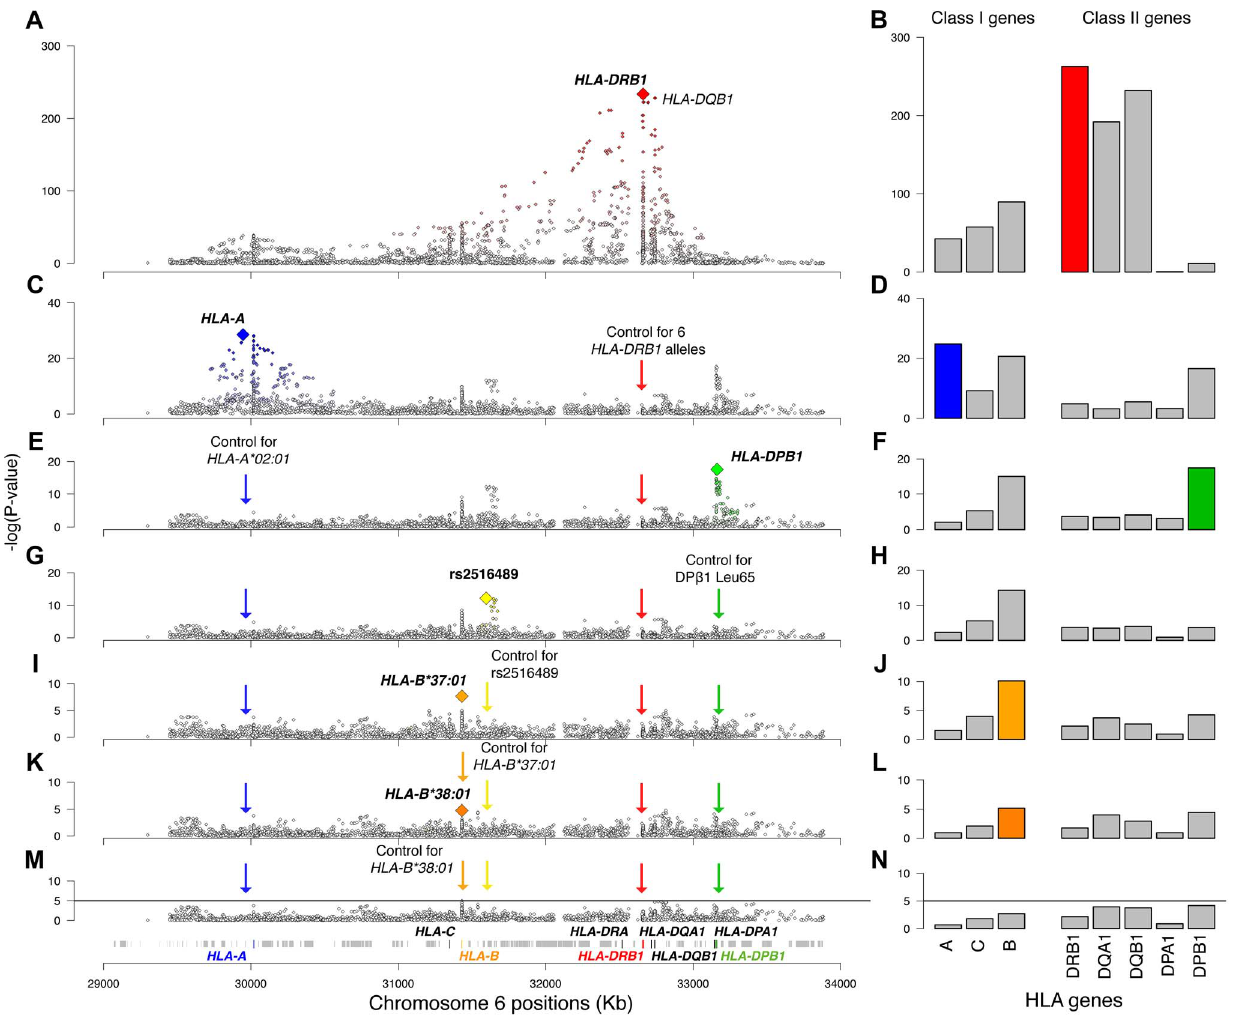
Figure 1. Association plots for the analyzed variants and HLA genes. Panels on the left are regional association plots for all variants in the MHC region; each diamond is a polymorphism evaluated in the analysis (SNP, HLA type, amino acid). The index variant that best captures the effect of each locus is highlighted with a larger diamond. Variants that are in LD with the index variant are colored, with the intensity of the color being proportional to the extent of LD. The panels on the right plot the 2 log 10 (p-value) of the eight analyzed HLA genes. The order of the genes is based on their position on chromosome 6. The rows represent univariate analysis (A, B), conditioning on six HLA-DRB1 alleles (*15:01, *03:01, *13:03, *04:04, *04:01, and *14:01) (C, D), conditioning on the above and HLA-A*02:01 (E, F), conditioning on the above and the DPB1 effect (G, H), conditioning on the above and rs2516489 (I, J), conditioning on the above and B*37:01 (K, L), conditioning on the above and B*38:01 (M, N). In panels M and N the solid black line marks the threshold of statistical significance in the